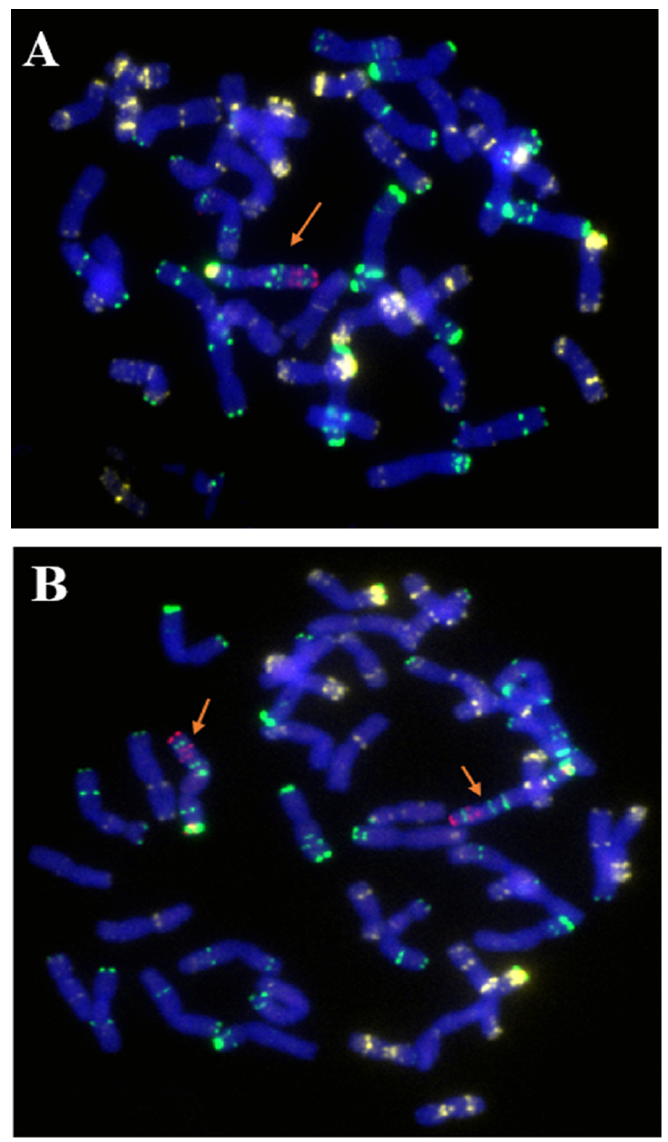
( A ) Resistance to stripe rust; ( B ) Resistance to powdery mildew. Left: 117-6, right: CN25.